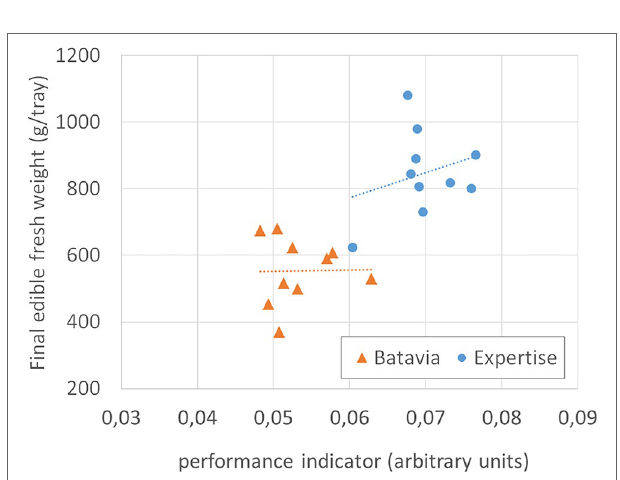
FIGUrE 11 | Final edible fresh weight (g/tray) of two cultivars of lettuce, vs the performance indicator, for all cycles long 37 through 39 days. The dotted lines are the linear best fit. The indicator cannot explain the variation in final weight of Lactuca sativa L., type Batavia, cv. “Othilie,” and rather poorly of Lactuca sativa L., type Crispy Green, cv.